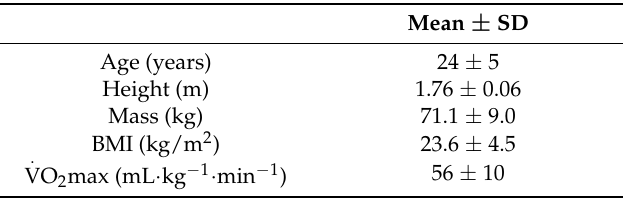
Table 1. Summary of participant characteristics, n =